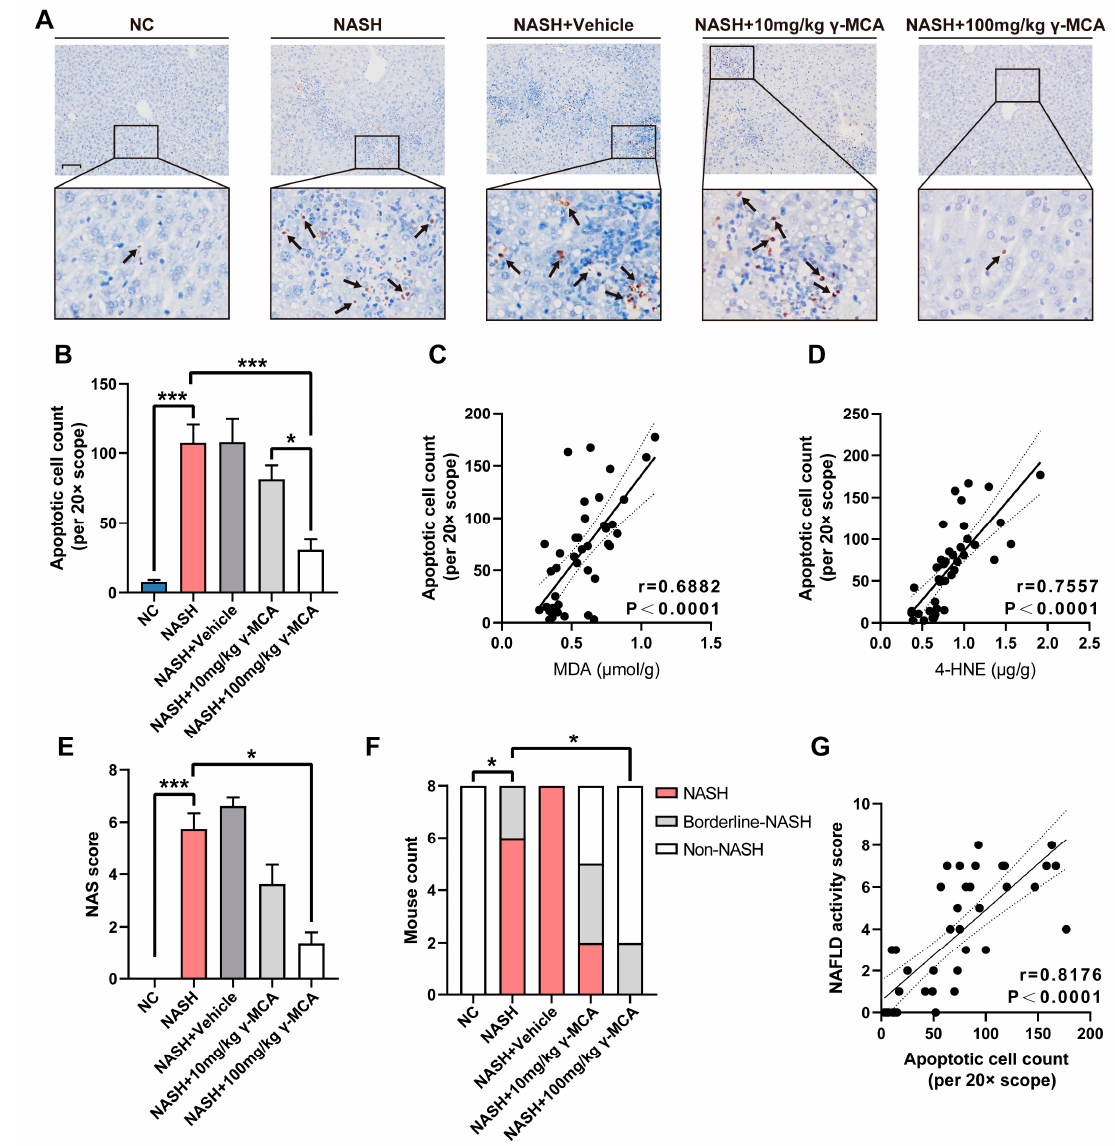
Figure 5. Relief of lipid peroxidative injury ameliorated hepatocyte apoptosis and NASH. ( A ) A TUNEL assay displayed plentiful apoptotic hepatocytes in lobular inflammatory foci of the NAFLD